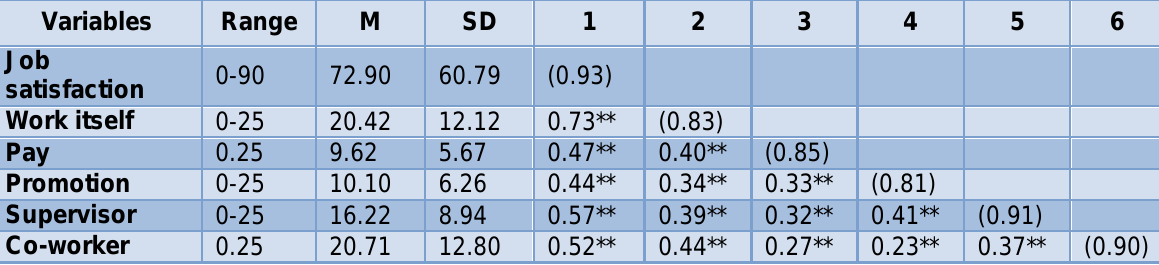
Table 2 means, standard deviations and correlations for overall job satisfaction and JDI facets of job